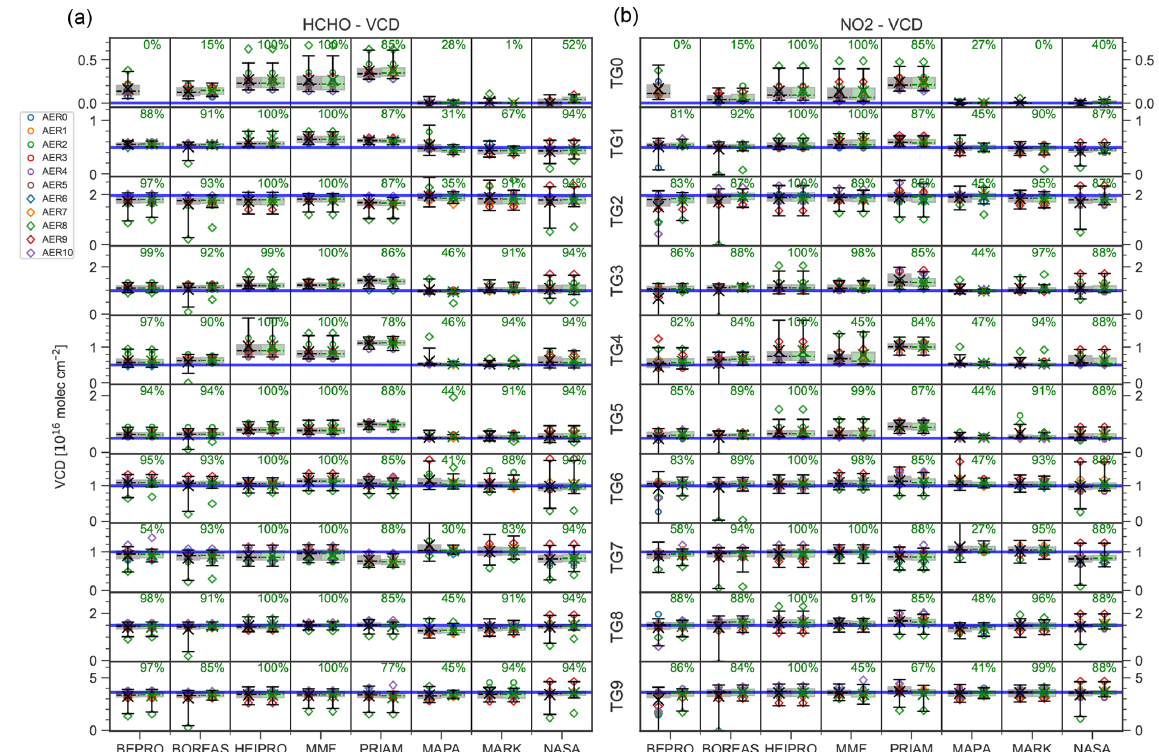
Figure 17. Box–whisker plots of the retrieved HCHO (a) and NO 2 (b) VCD for the different trace gas scenarios (rows) and retrieval algorithms (columns) based on retrievals using noisy dSCDs. Crosses show the mean, and dashed horizontal lines show the median. Shaded areas indicate the (25%–75%) percentile, and whiskers show the (5%–95%) percentile. The true VCD is shown as a blue horizontal line. For each algorithm, all data are shown on the left in black, and data marked as valid are shown on the right in green. Also shown is the percentage of valid data. The median for each aerosol scenario is shown as a coloured symbol as indicated in the